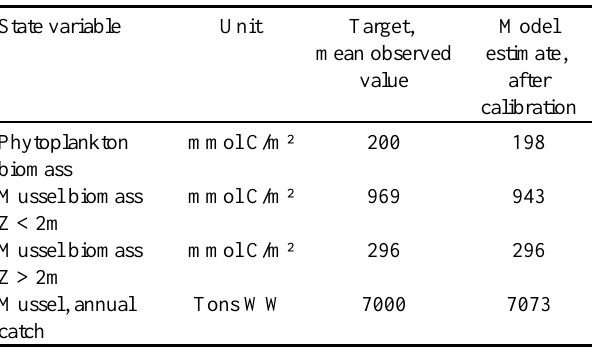
Table 1. State variables used for calibration of the ecological- social-economic (ESE) model, equal to the average of the annual mean values over the modeled 19 year period from